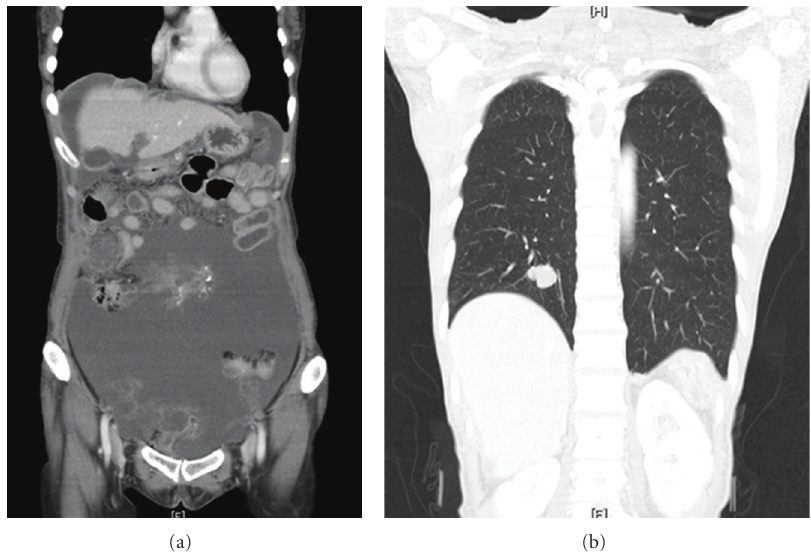
Figure 1: CT at the time of referral: massive tumor was di ff usely spread in the peritoneal cavity. A solitary nodule in the right lower lung was also observed.